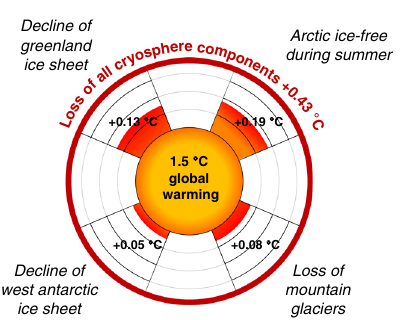
Fig. 2 GMT increase through disappearance of cryosphere elements. The additional warming for the cryosphere components is shown for a scenario consistent with global warming levels of 1.5 °C. Radially outward, the temperature anomaly is displayed which arises from the disappearance of the cryosphere elements. The thick dark red line indicates the maximum effect of additional warming in case all cryosphere elements lose stability. All values are the medians of the ensemble.